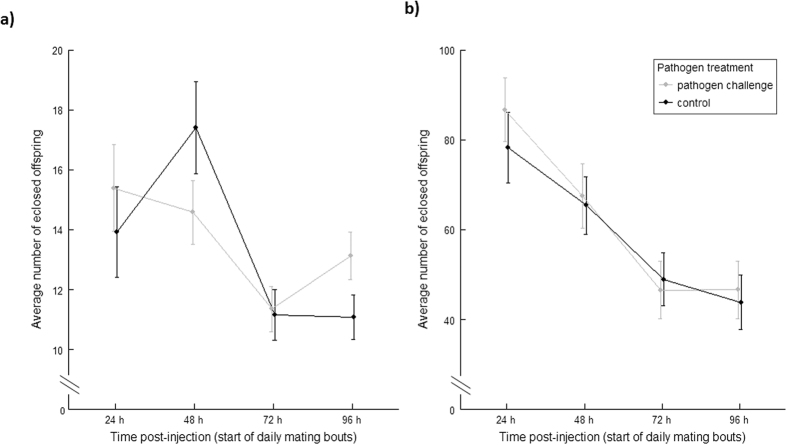
Effect of pathogen treatment on reproductive success across four days of ovipositing (X ± SE).Note that the focal females (a) and males (b) are increasing in age across the four day mating assay, whereas the tester females and males are kept at a standardized (3–4 d) age throughout. (a) Female reproductive success, Nindividuals = [pathogen challenge/control]: [66/63]. (b) Male reproductive success, Nindividuals = [pathogen challenge/control]: [63/67].